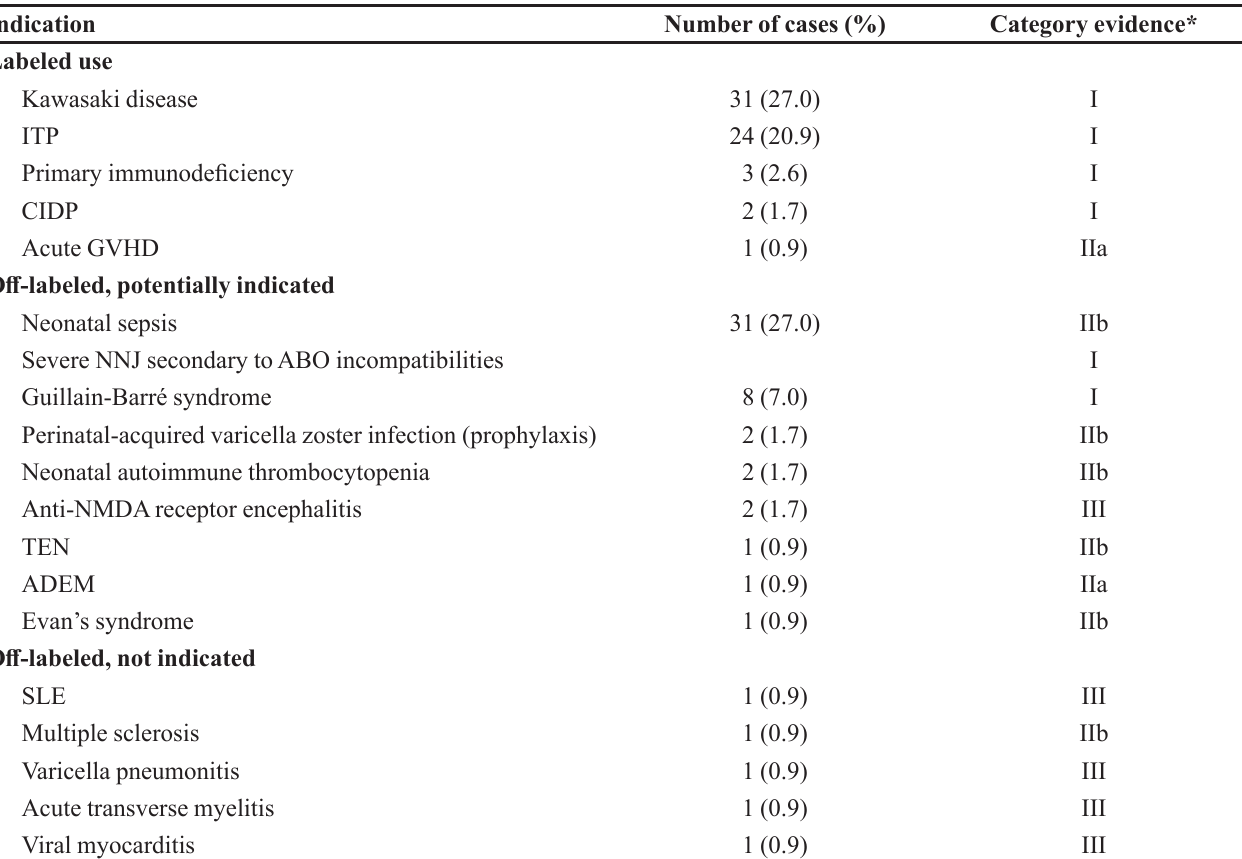
TABLE II – Utilization of IVIG by indication and evidence category